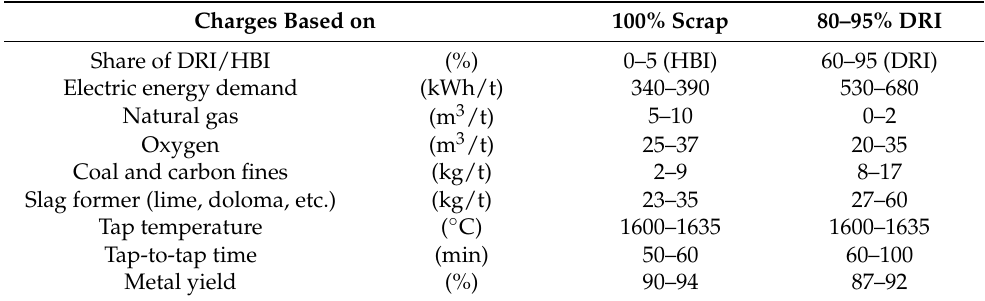
Table 2. Range of typical production parameters of electric arc furnace (EAF) charges with scrap and scrap/DRI, respectively, for low alloyed steel grades.